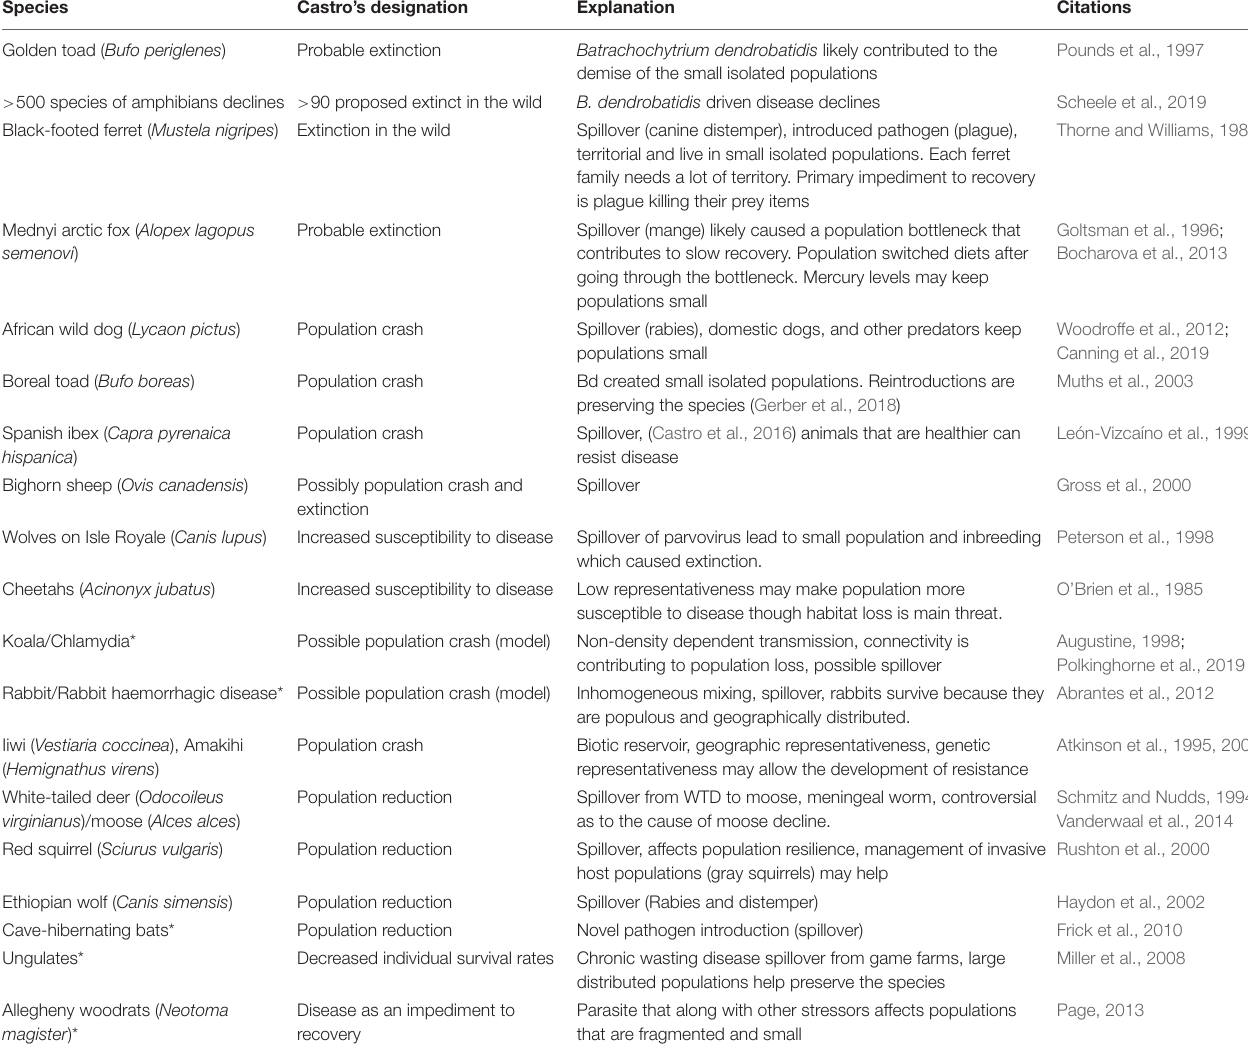
TABLE 2 | List of empirical examples where organisms have been negatively affected by disease.